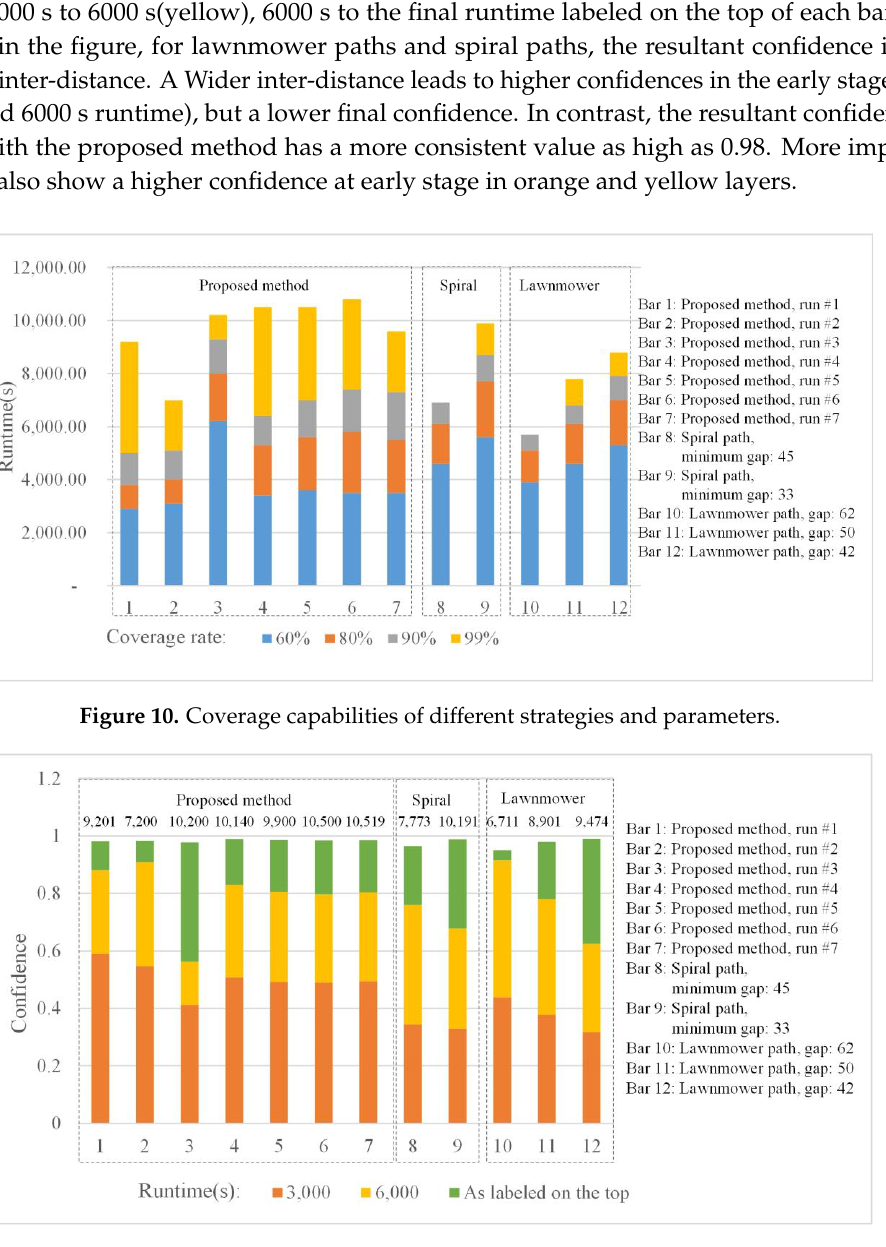
Figure 11. Confidence comparison of different strategies and parameters. The confidence refers to the average confidence of the cells in the